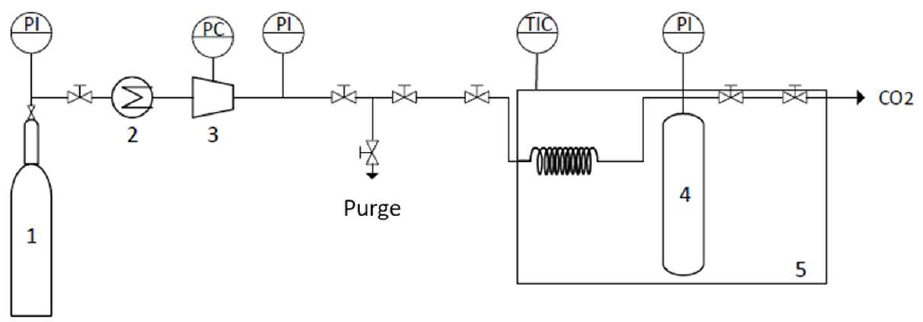
Figure 8. Schematic representation of the scCO 2 drying apparatus: (1) CO 2 tank, (2) Cooler, (3) Compressor, (4) Reactor, and (5) Thermostat water bath.